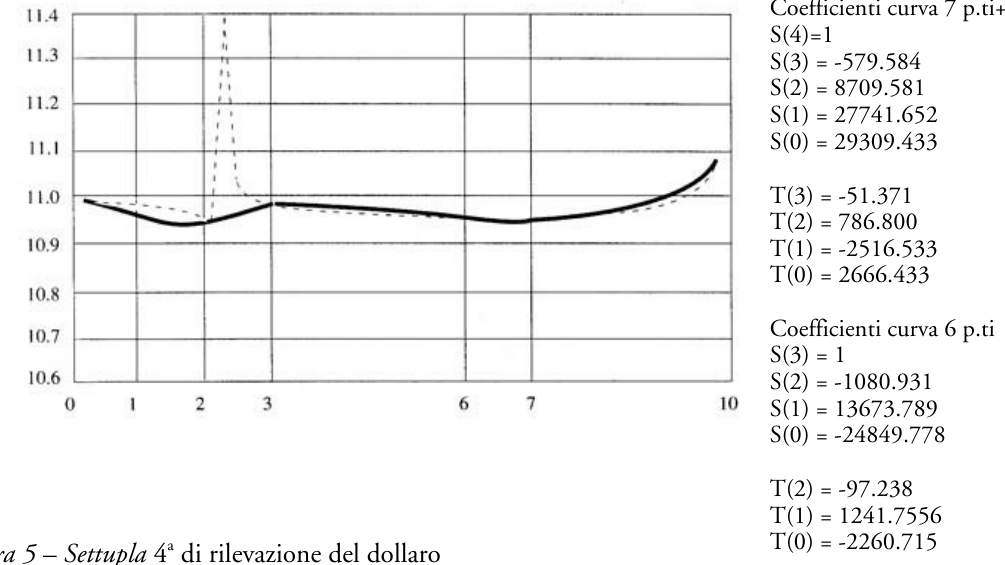
Figura 5 – Settupla 4 a di rilevazione del dollaro La curva in linea continua passa per i 7 punti dati e non presenta discontinuità, quella tratteggiata passa per gli stessi punti escluso il secondo. Le discontinuità non possono essere